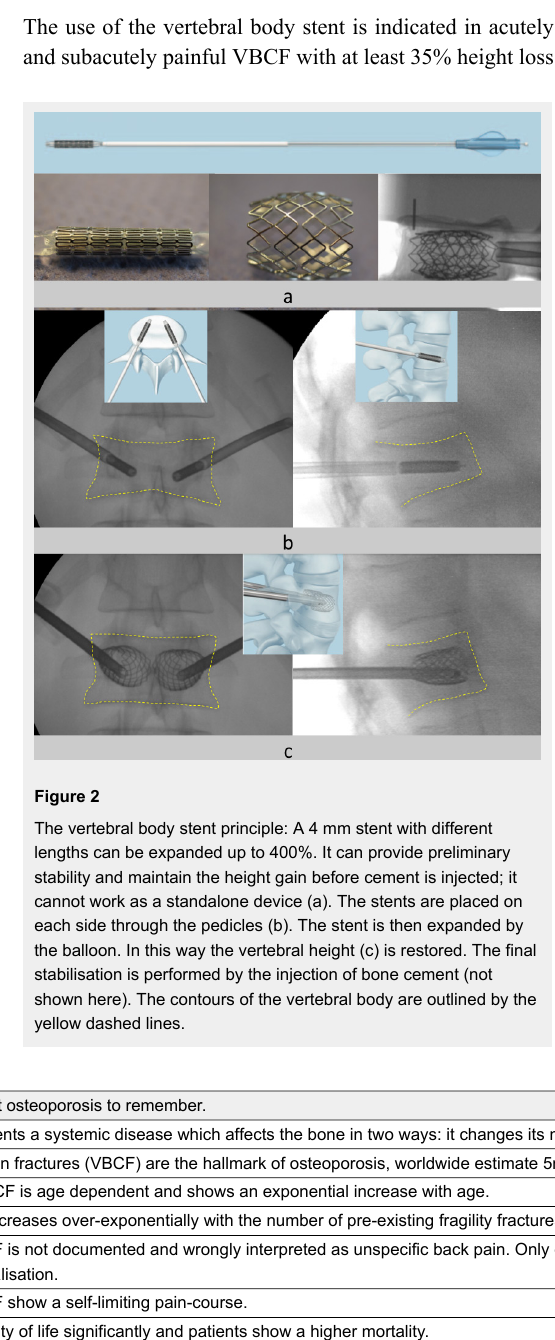
Table 1 : Facts about osteoporosis to remember. Osteoporosis represents a systemic disease which affects the bone in two ways: it changes its mineral content but also its structural architecture. Vertebral compression fractures (VBCF) are the hallmark of osteoporosis, worldwide estimate 5m fractures per year. The incidence of VBCF is age dependent and shows an exponential increase with age. The fracture risk is increases over-exponentially with the number of pre-existing fragility fractures. The majority of VBCF is not documented and wrongly interpreted as unspecific back pain. Only one third of all fractures gain clinical attention and one fourth out of this group require hospitalisation. The majority of VBCF show a self-limiting pain-course. VBCF affect the quality of life significantly and patients show a higher mortality. VBCF can result in severe complications with neural compression/paralysis, mechanical instability/non-union. Injection of PMMA into the vertebral body provides mechanical stability; furthermore it prevents further sintering. Stabilization of a fracture provides pain